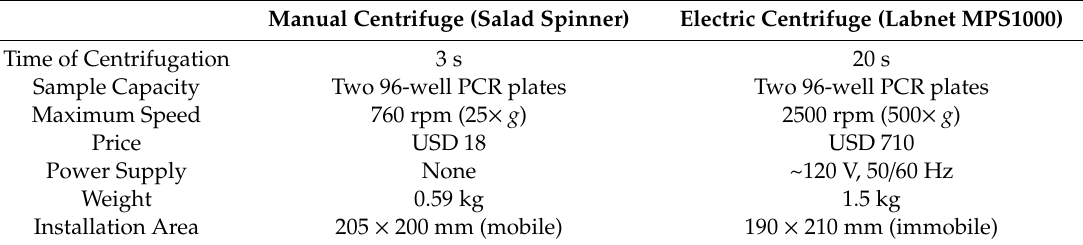
Table 2. Features of manual and electric centrifuges for 96-well PCR